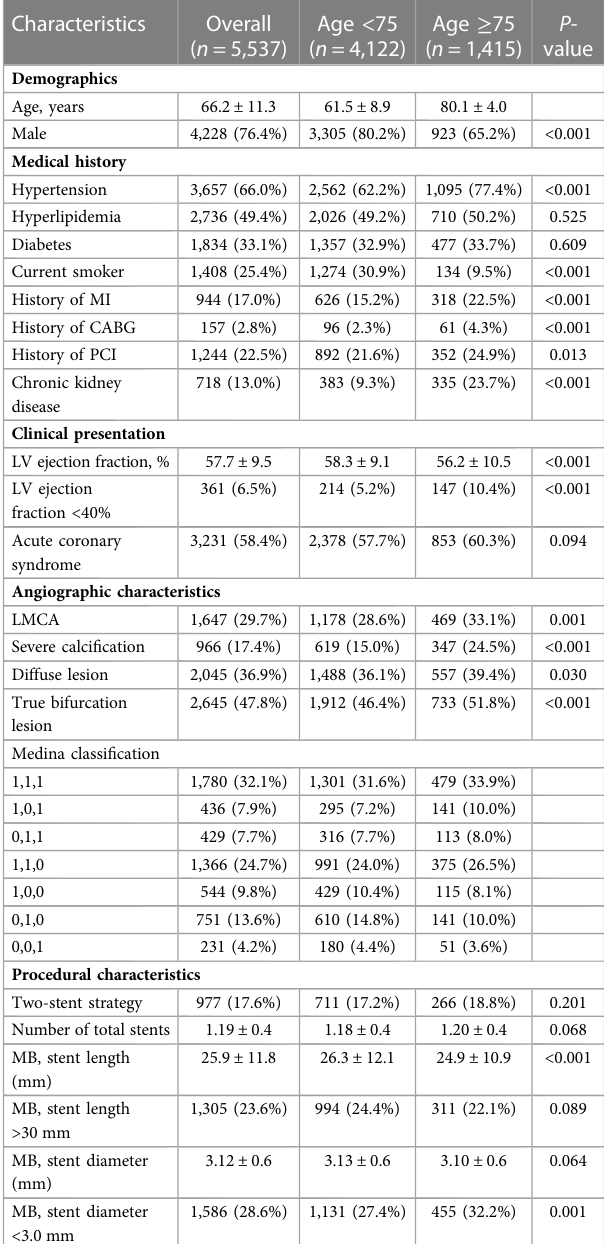
TABLE 1 Comparison of clinical